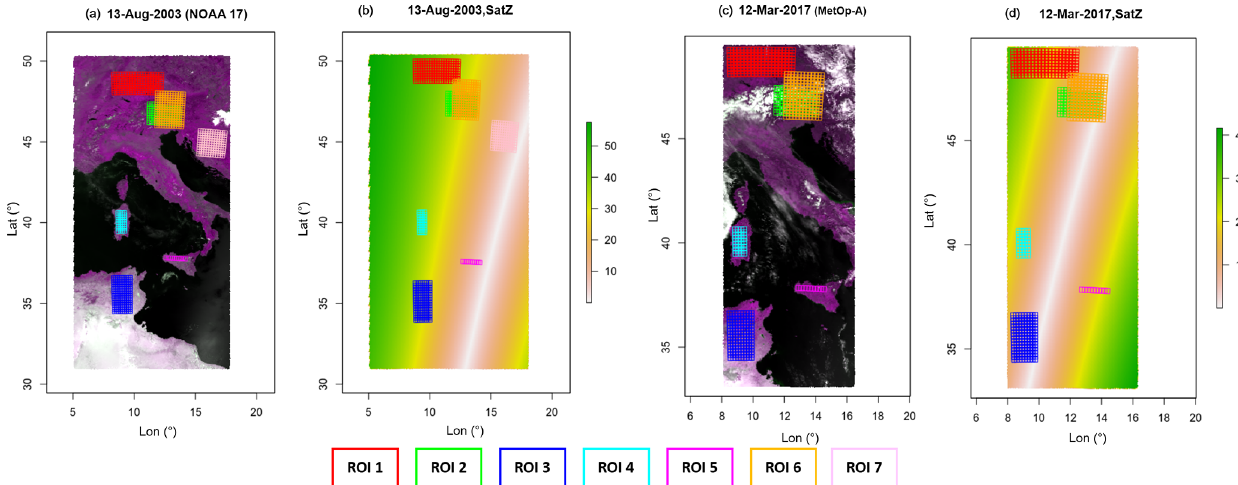
Figure 1. Top-of-atmosphere reflectance true color composite (AVHRR GAC bands 2-1-2) surrounding the study area (a, c) and the dis- tribution of ROIs (as defined by rectangles with different colors) over the study area. Panels (a) and (c ) are the data from NOAA-17 and MetOp-A satellites on 13 August 2003 and 12 March 2017, respectively. Panels (b) and (d) are their corresponding SatZs, respectively, which is indicated by the color bar, with the white line representing small SatZs along the satellite path. These data are available from the ESA CCI (Climate Change Initiative) cloud project (Stengel et al.,